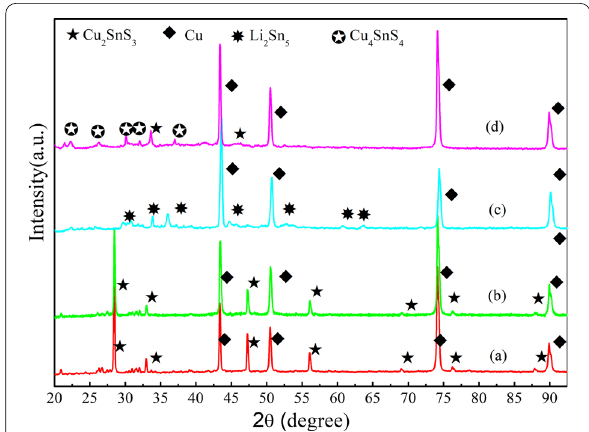
Fig. 6 Ex situ XRD patterns of the electrode; a as-prepared; b first discharged to 1.5 V; c first discharged to 0.05 V; d second charged to 2